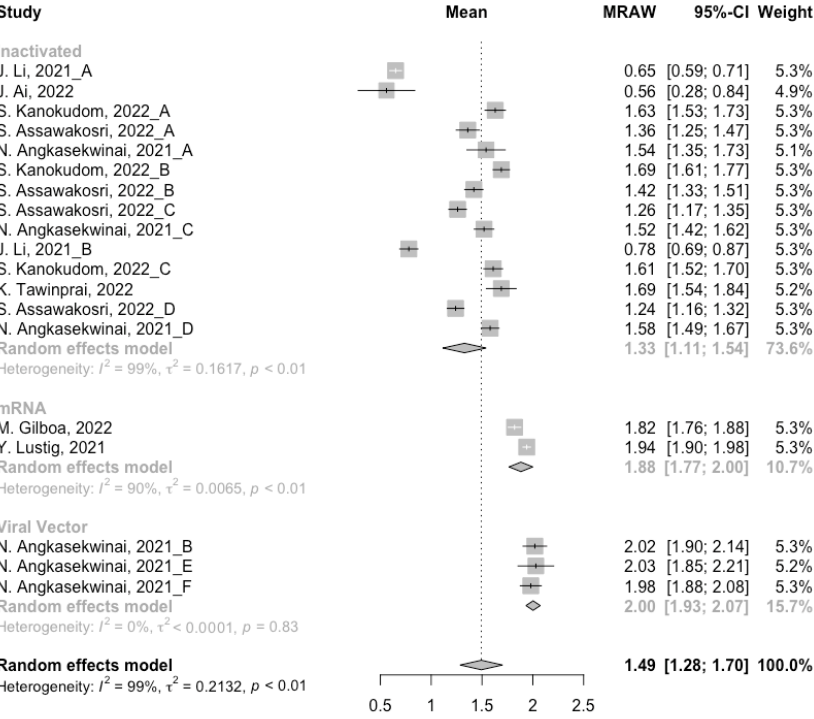
Figure 4. Forest plot of the pooled seropositive rate of antibodies before booster vaccination.